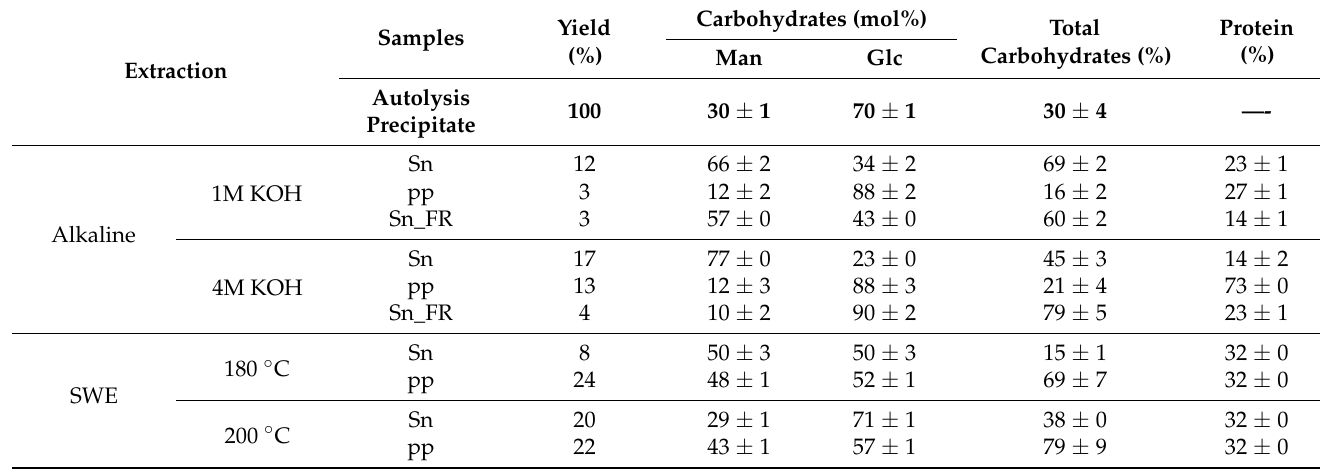
Table 1. Yields, carbohydrate, and protein composition of brewer’s spent yeast extracts.